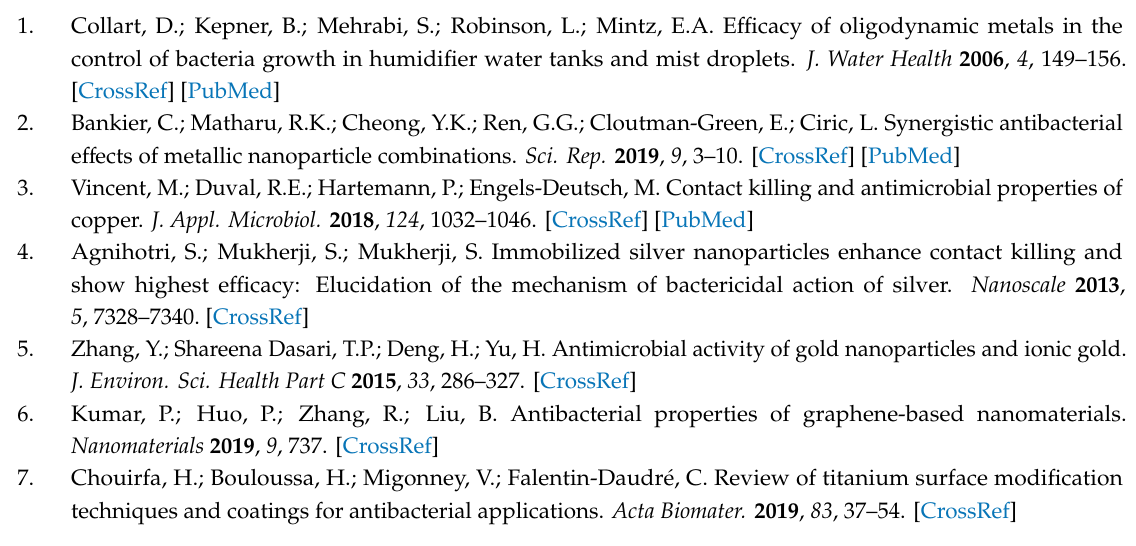
Figure S1: (a,c,d) Au(E) and (b) Au200 surfaces after Gram-staining measurements for (a,b) L. rhamnosus GG, (c) L. plantarum 299v, and (d) L. acidophilus cultivated 48 h, Figure S2: Results of GPC for dex6, dex40, and dex100. Experimental parameters were as follows: flow rate—1 mL · min − 1 ; injection volume—100 µ